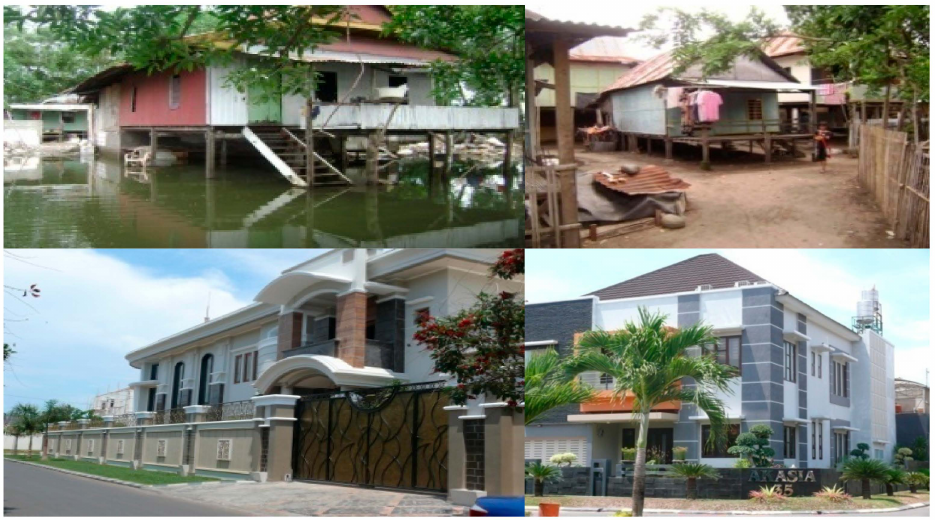
Figure 13. Spatial segregation and di ff erences in residential types in the new city area of Metro Tanjung Bunga. Source: Primary